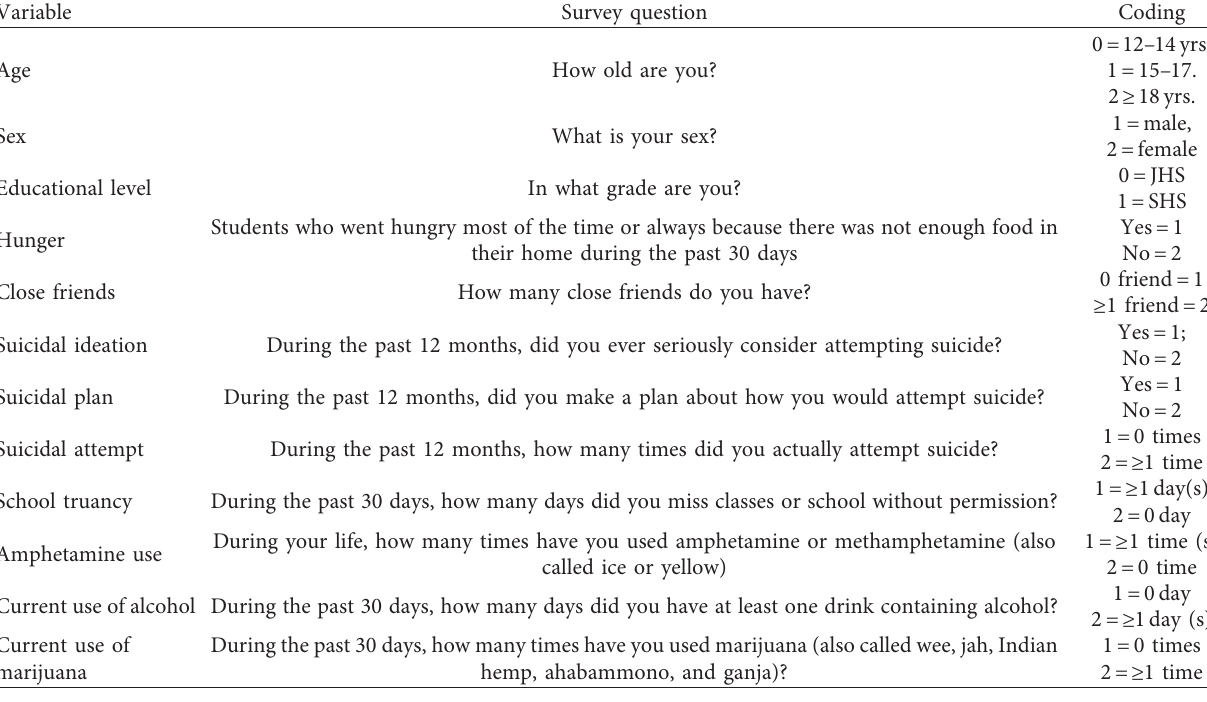
Table 1: Explanatory variables data derivation from the